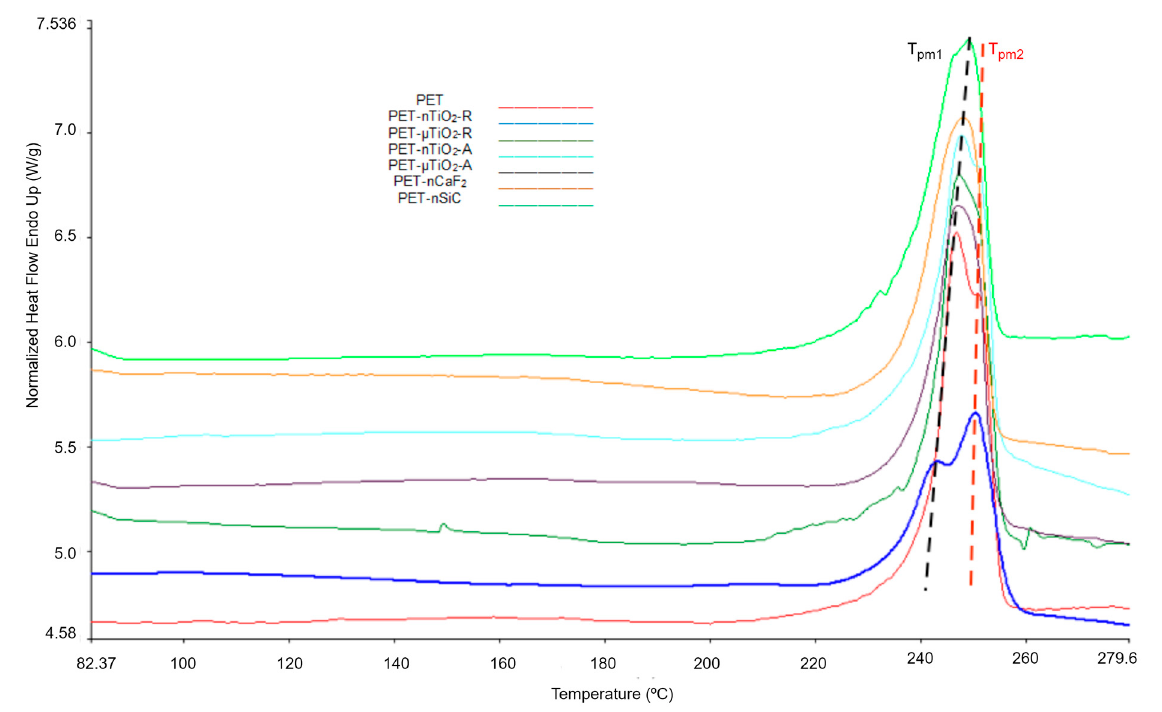
Figure 5. Thermograms corresponding to the first heating of the yarns after 170 days of exposure.